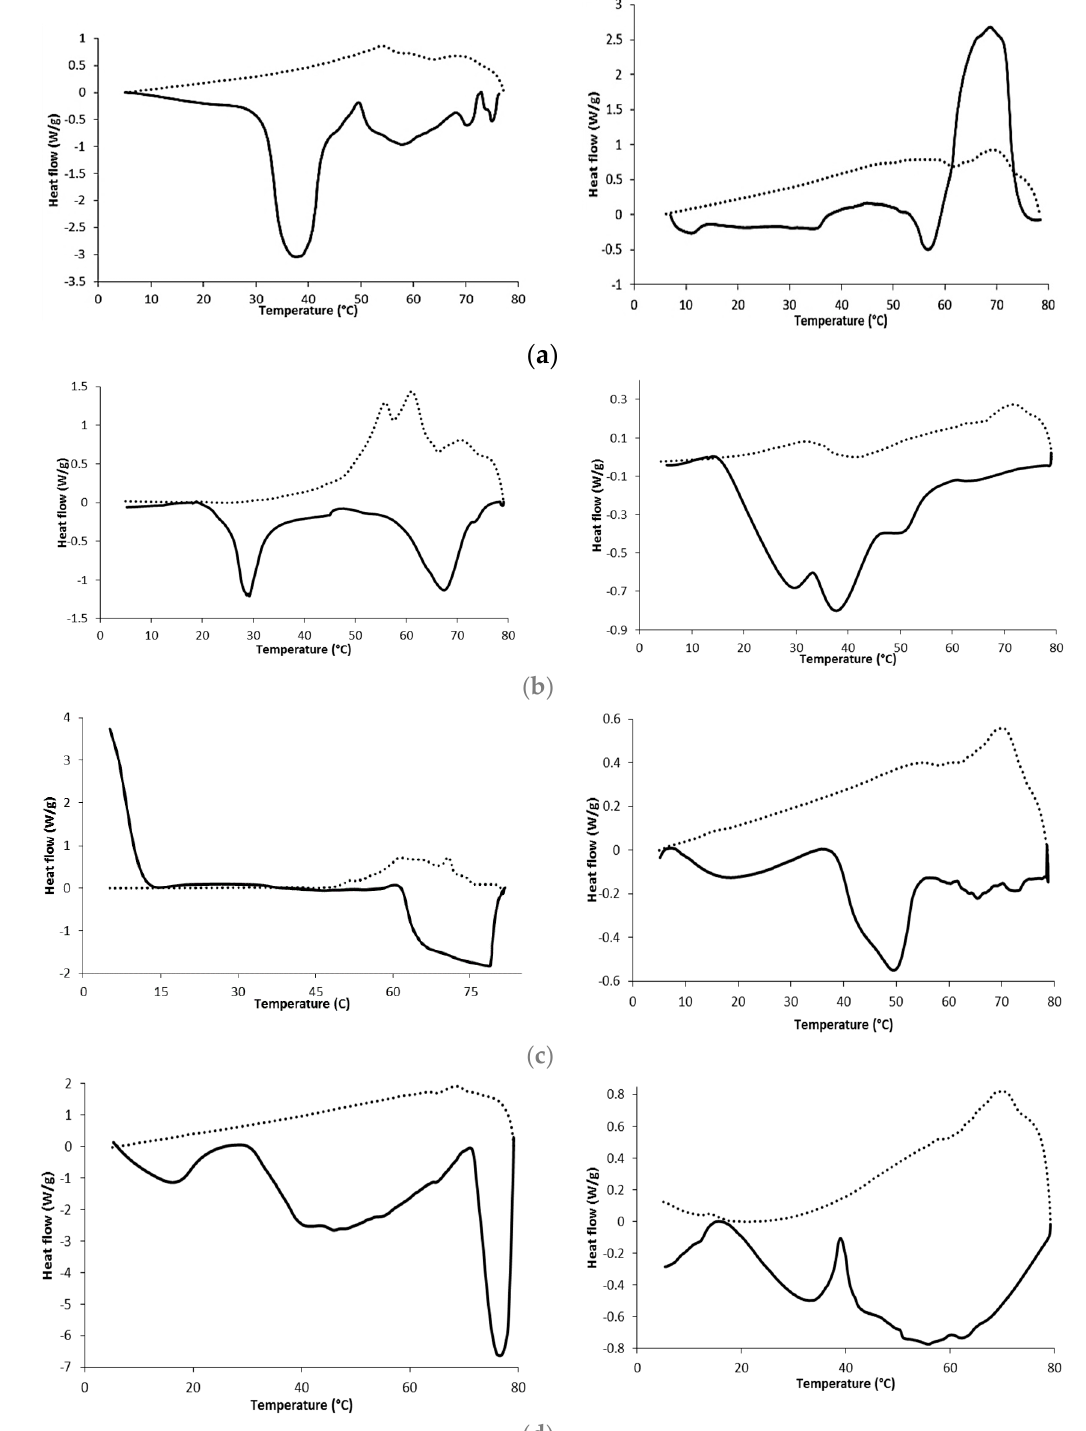
Figure 1. Wide angle X-ray diffraction for waxy emulsifiers. ( A ). carnauba wax, ( B ). candelilla wax, ( C ). beewax, ( D ). ozokerite wax, ( DC ). Degree of crystallinity. Figure 2 depicts the thermograms that result from the crystallization profile (dotted lines) and melting profile (straight lines) of the neat waxes (left panel) and their matrix systems (right panel).